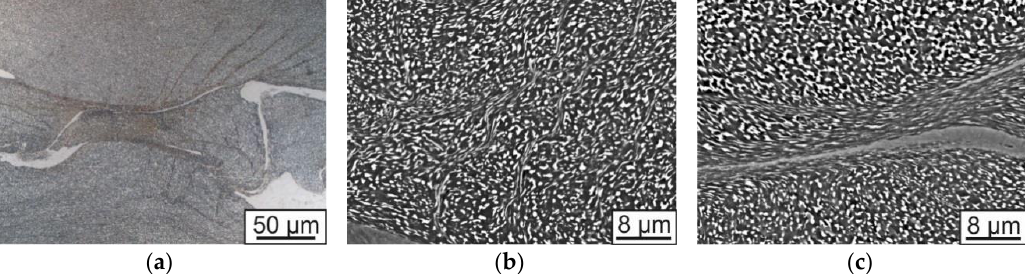
Figure 4. Shear bands near the VT23–VT14 interfaces obtained by explosive welding: ( a ) light microscopy image; ( b , c ) Scanning electron microscope (SME) images.